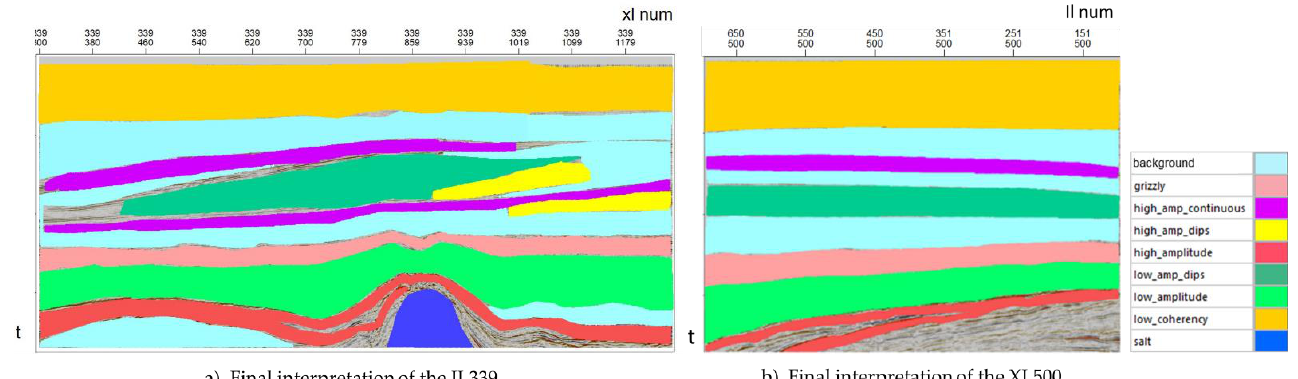
Figure 3. Final interpretation of the IL339 ( a ) and the XL500 ( b ) used as input data for the algorithms. The unlabeled parts were either labeled as background facies or were not taken into account in the training dataset, depending on the algorithm. In the test dataset, unlabeled samples were ignored.